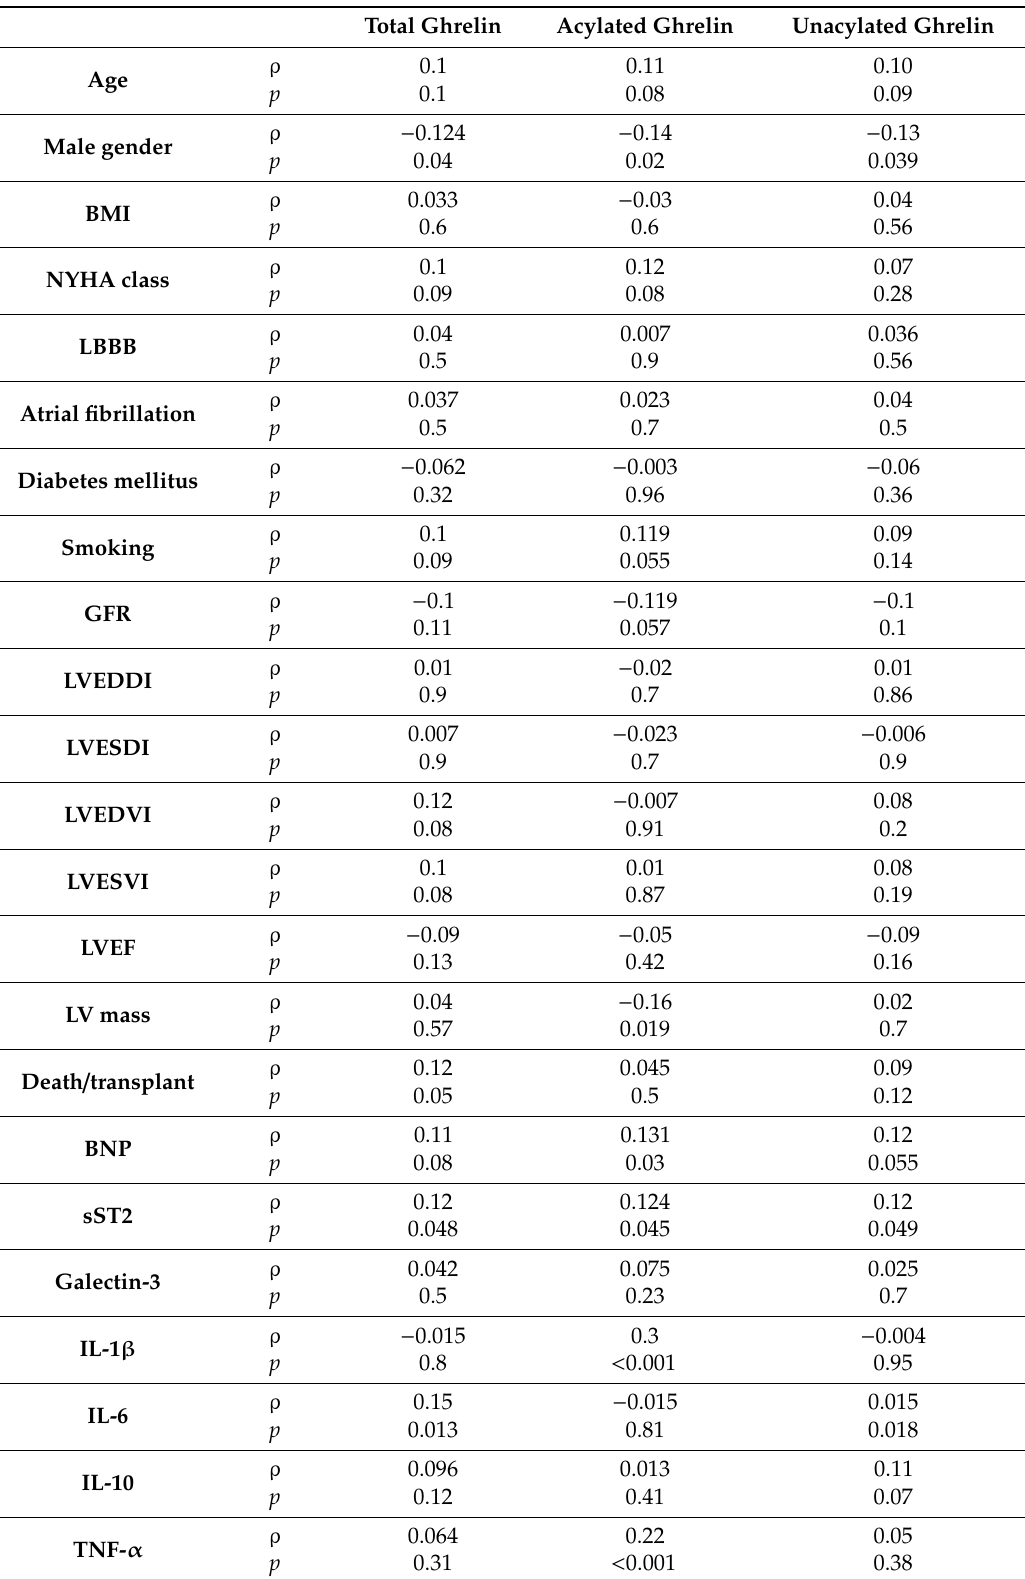
Table 5. Correlations between serum biomarkers and clinical-instrumental parameters in patients with